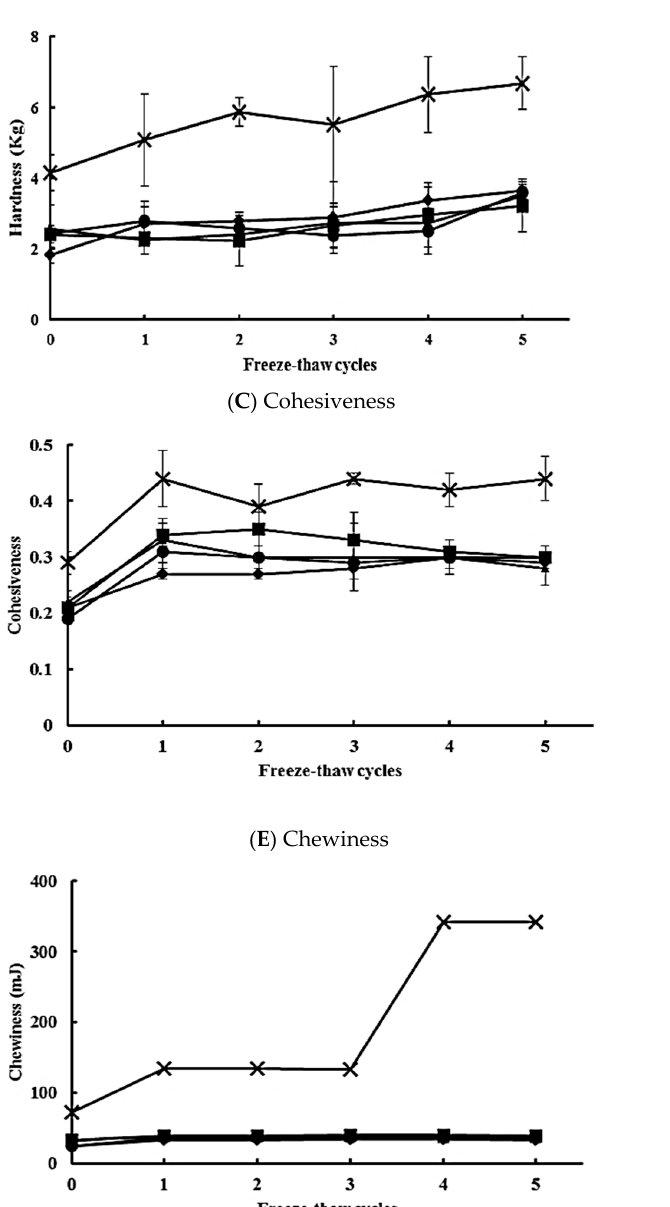
Figure 1. Texture profile analysis (TPA) of chicken meatballs during five freeze-thaw cycles (F-T cycles). ( A ) Hardness. ( B ) Springiness. ( C ) Cohesiveness. ( D ) Gumminess. ( E ) Chewiness. CS, corn starch ( ▲ ); QS, quinoa starch ( (cid:4) ); Q, quinoa seed ( × ); CS-Q, corn starch and quinoa seed ( ● ); QS-Q, quinoa starch and quinoa seed ( ♦ ).